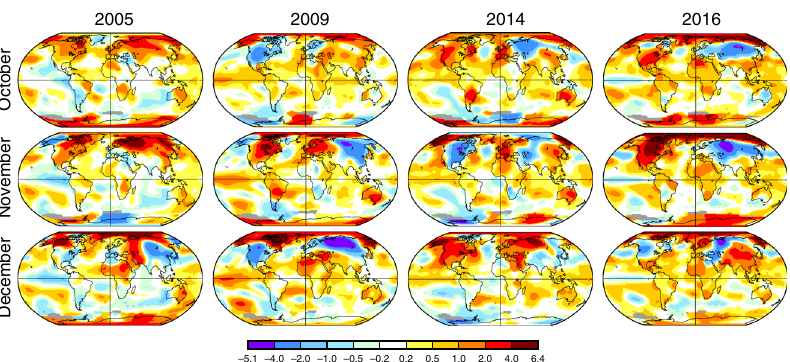
Fig. 7 Word temperature anomaly maps. The temperature anomaly maps for the months of October, November and December of the years during which an intercontinental HPAI H5 spread was reported — 2005, 2009, 2014 and 2016 — were obtained from the National Oceanic and Atmospheric Administration (NOAA) 46 at https://www.ncdc.noaa.gov/sotc/global/201709 by comparing the land and ocean surface temperatures of a given month to the average values for that month for the period 1901 – 2000. A positive anomaly (red) indicates that the observed temperature was warmer than the reference value, while a negative anomaly (blue) indicates that the observed temperature was cooler than the reference value. Temperature anomaly in degrees Celsius.